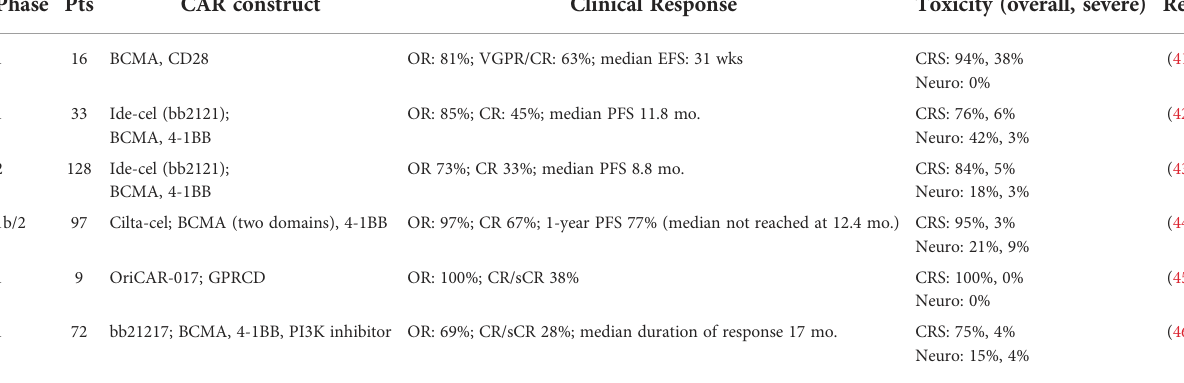
TABLE 1 Selected published and ongoing clinical trials of CAR T cells in